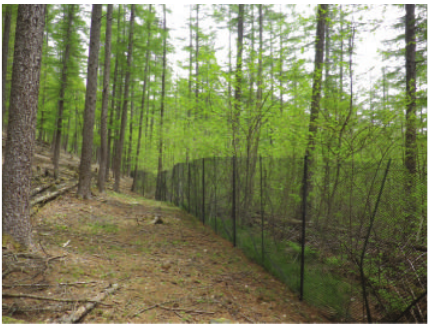
Figure 1: View of the eight-year-old deer exclosure in a larch forest in Okutama, western Tokyo, Japan. Photo taken in May, 2011.